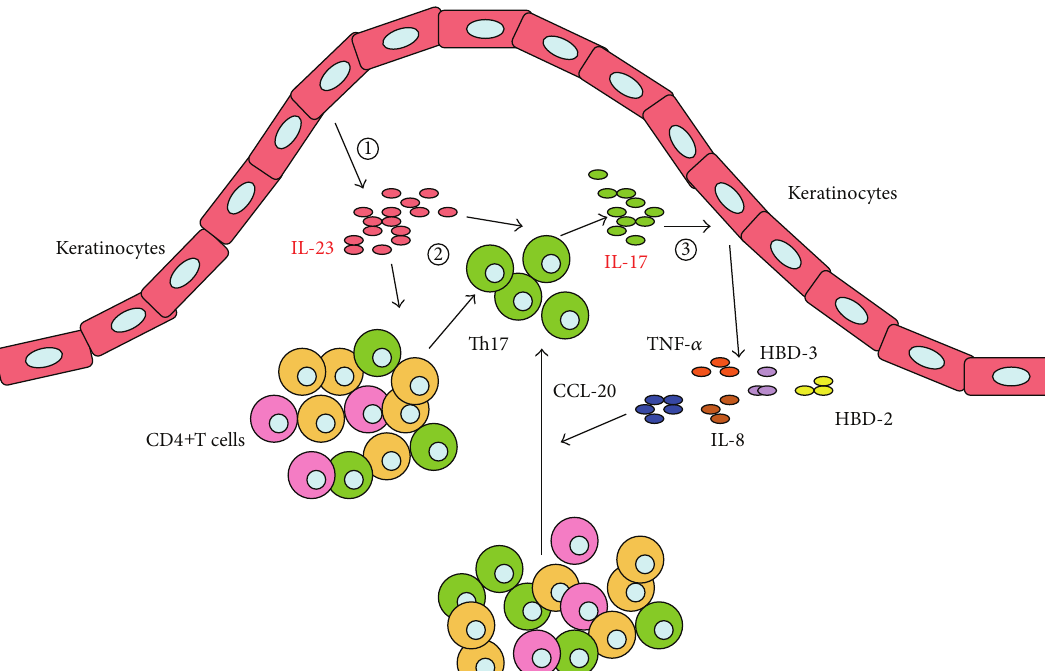
Figure 6: Schematic model of IL-23/IL-17 axis involved in the pathogenesis of OLP. The whole process is divided into three steps: (1) keratinocytes in OLP lesion produce a large amount of IL-23 via an unknown mechanism; (2) keratinocyte-derived IL-23 may contribute to the accumulation of Th17 cells and the overproduction of IL-17 in the local lesion of OLP; (3) IL-17 reversely induces the keratinocytes to selectively produce various inflammatory mediators, which compose the complex immune network in the inflammatory environment of OLP